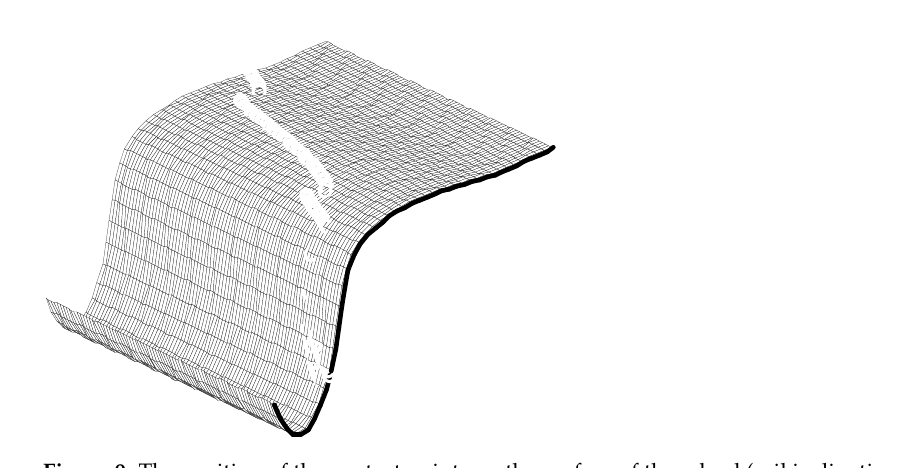
Figure 8. The position of contact points on the surface of the rail (rail inclination = 0).